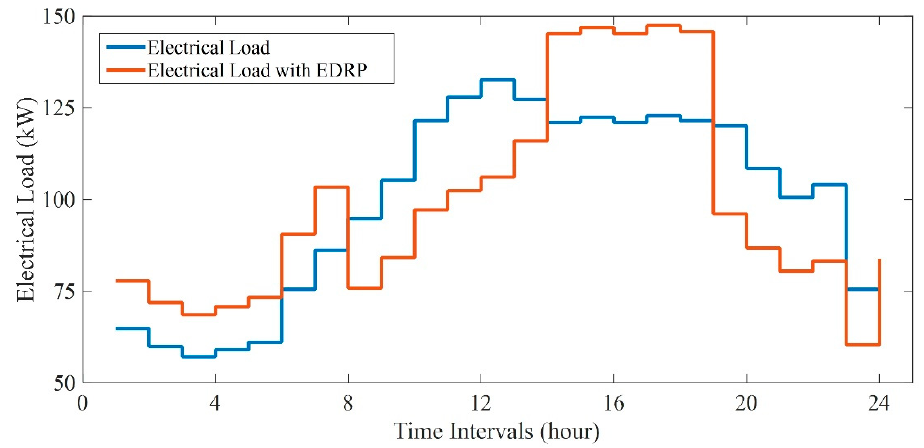
Figure 7. Electrical load with/without EDRP on the typical summer day.